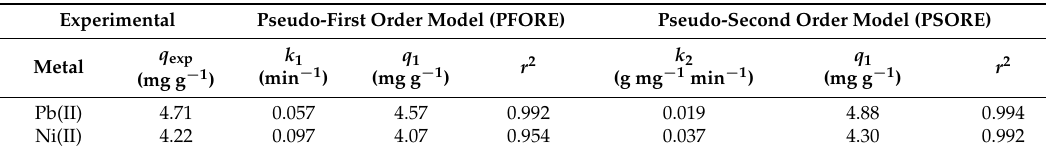
Table 4. Kinetic parameters of CAM-D2EHPA sorbent.